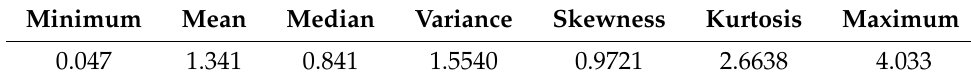
Table 3. Descriptive statistics of the survival data set.